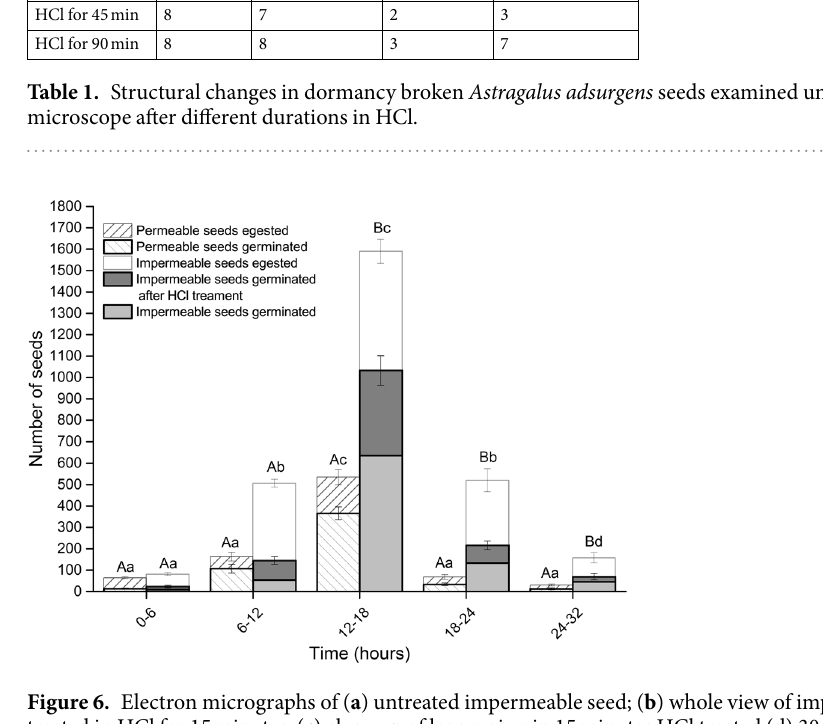
Figure 6. Electron micrographs of ( a ) untreated impermeable seed; ( b ) whole view of impermeable seed treated in HCl for 15 minutes; ( c ) close-up of lens region in 15 minutes HCl treated (d) 30 minutes HCl treated ( e ) lens region in 45 minutes HCl treated; ( f ) whole seed view after 45 minutes HCl treated; ( g ) close-up of cracks in 45 minutes HCl treated; ( h ) whole seed view after 90 minutes HCl treated; ( i ) whole seed view after 90 minutes HCl treated showing smaller cracks; ( j – l ) completed damaged coats after 90 minutes HCl treated Astragalus adsurgens seeds. H, hilum; M, micropyle; HS, Hilar slit; L, lens; C,